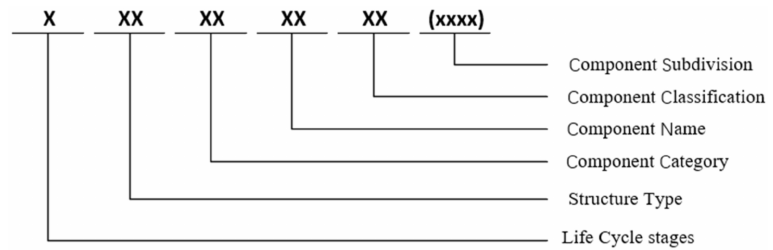
Figure 2. The coding